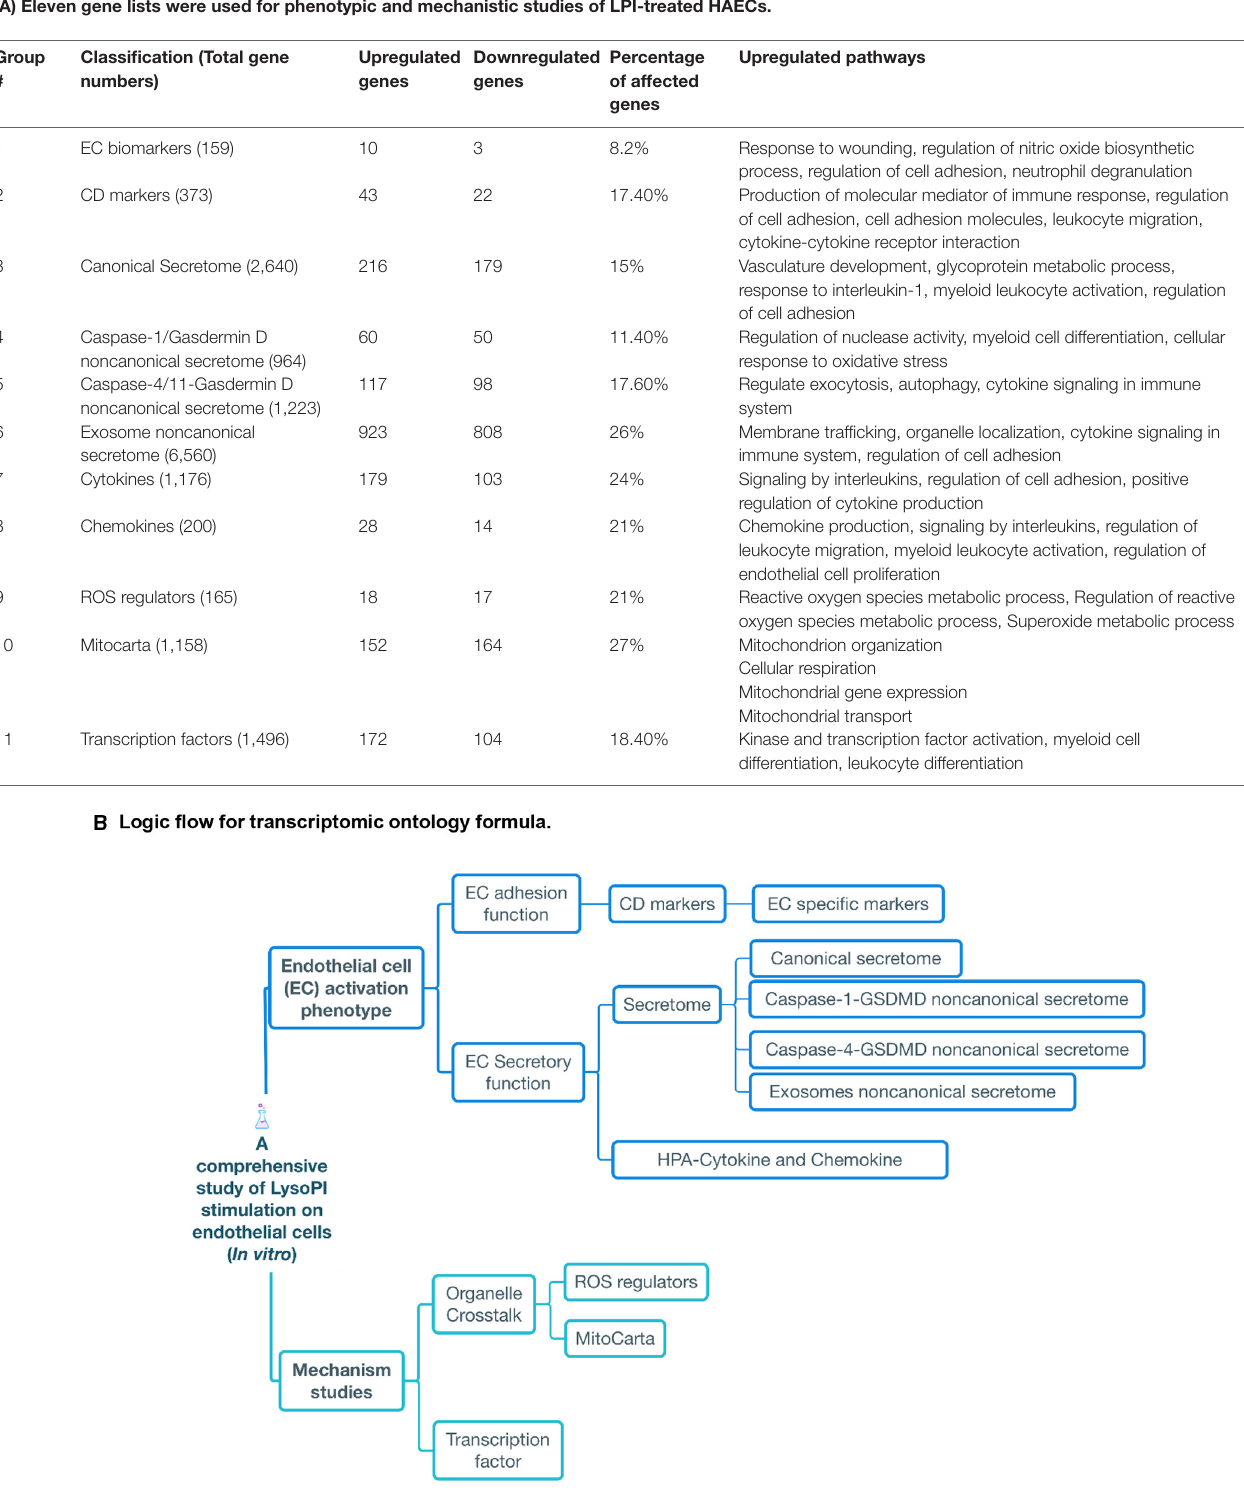
FIGURE 1 | Comprehensive analysis of lysophosphatidylinositol LPI)-treated human aorta endothelial cells (HAECs) at messenger RNA (mRNA) level from 11 different aspects. (A) Phenotypic and mechanistic studies. The table shows how a gene changes 18h after HAECs were treated with 10 µ M LPIs. The last column indicates that the pathways are promoted by LPI-upregulated genes. Pathways associated with endothelial cell activation are marked in red. (B) Logic flow for our knowledge-based transcriptomic profile strategy.